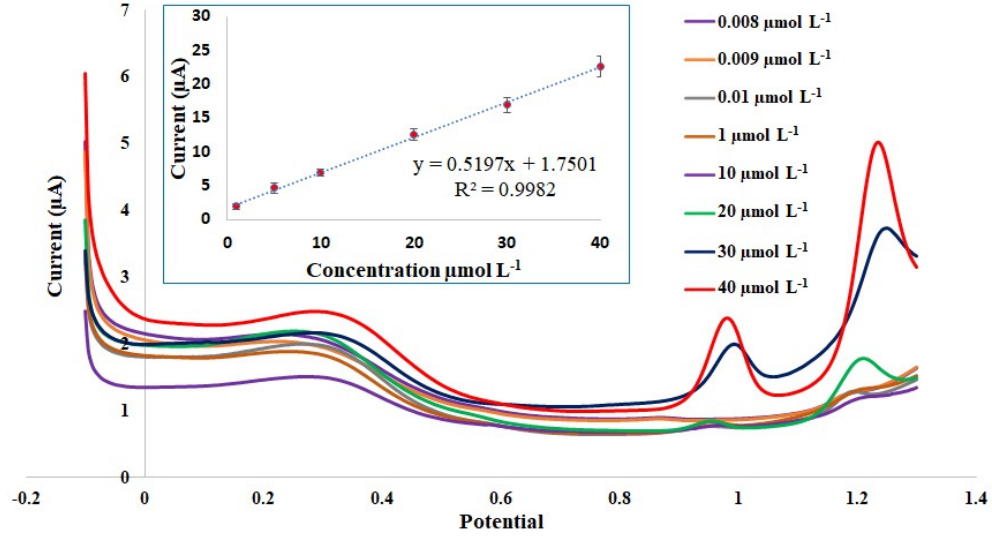
Figure 5. Dependence of the ABZ oxidation peaks on concentrations. Table 1. Comparison of the activity of Pt-Pd/GCE for ABZ detection with other techniques.